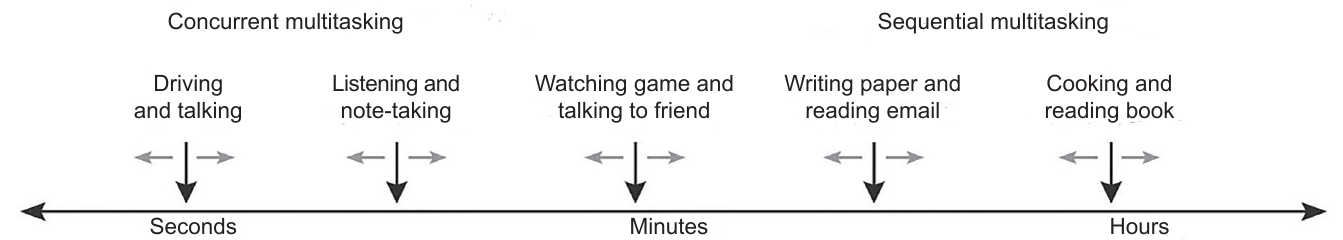
Figure. The multitasking continuum.